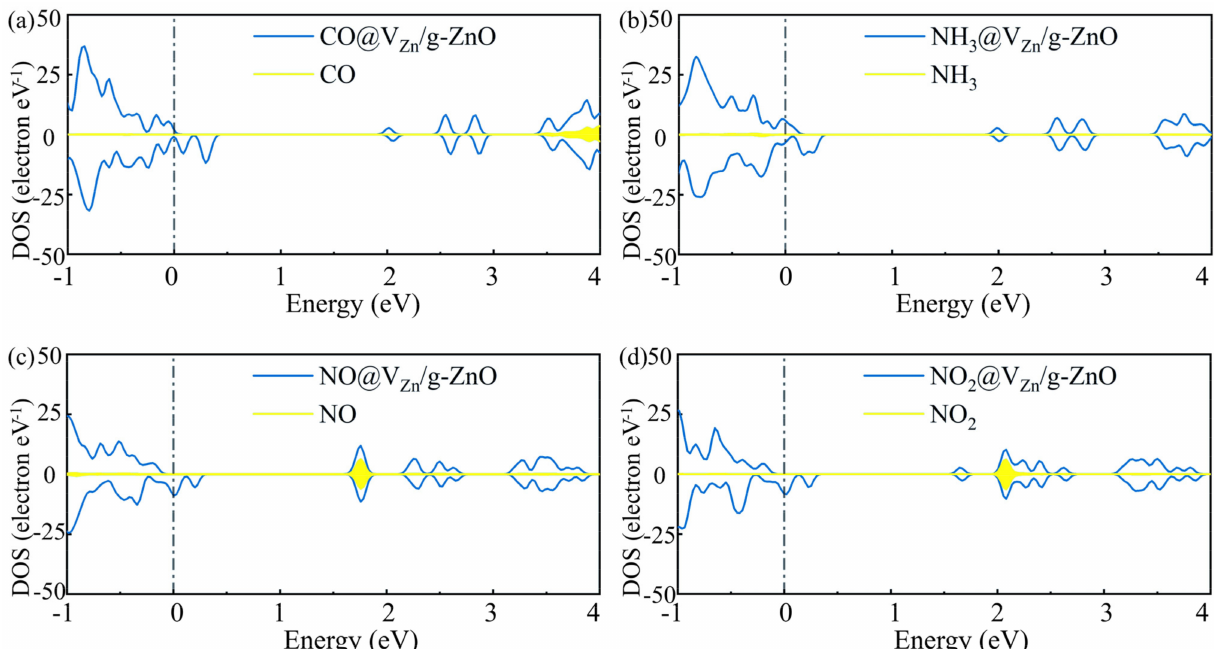
Figure 9. DOS of ( a ) CO, ( b ) NH 3 , ( c ) NO, or ( d ) NO 2 adsorbed on V Zn /g − ZnO systems.